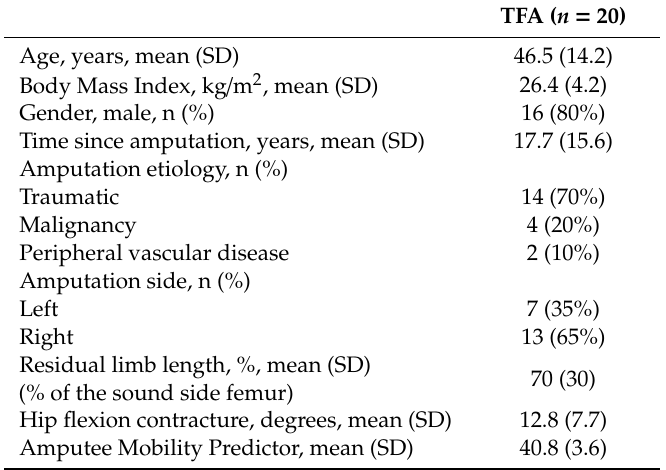
Table 1. Demographics and characteristics for individuals with unilateral transfemoral